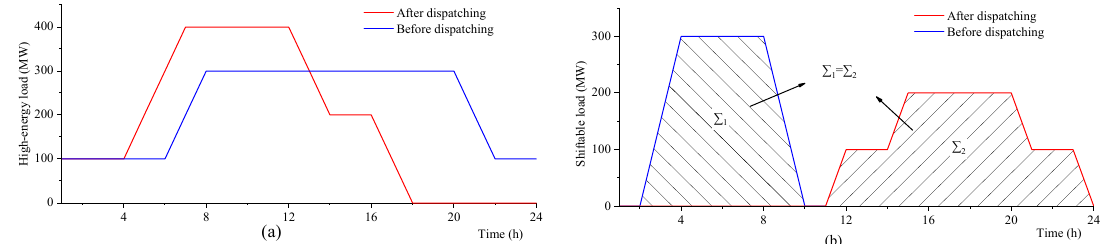
Figure 1. Introduction of an HL and an SL. ( a ) The scheduling characteristic of an HL. ( b ) The scheduling characteristic of an SL.